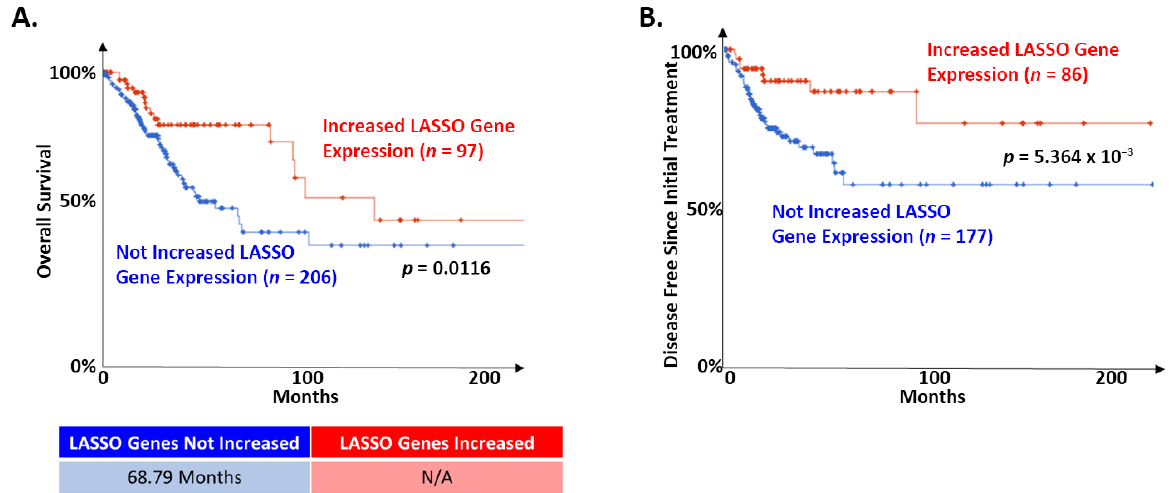
Figure 3. LASSO-identified genes are positive prognostic factors in cervical cancer. The TCGA cervical cancer dataset was segregated based on the expression of LASSO-identified genes as described in the text. ( A ) Of the 303 samples in the TCGA dataset with information on overall survival, 97 had altered expression of at least one LASSO-identified gene. The remaining did not have increased expression of nine LASSO-identified genes (CEBPD, SPRR2G, RAB7B, NOTCH1, KRT16, LCE1B, SLPI, RPS29, and PPL; z-score > 2). Kaplan–Meier curves of the two populations are shown. Median survival for each group is shown below the curve. N/A indicates that the group with altered expression of LASSO-identified genes did not drop below 50%. ( B ) Of the 263 samples in the TCGA dataset with information on maintenance of disease-free status after initial treatment, 86 had increased expression of at least one of the nine LASSO-identified gene analyzed in A. The remaining did not have increased expression of these genes. Kaplan–Meier curves of the two populations are shown. The median survival is not shown because neither group dropped below 50%. For all, the significance of the difference between the two groups was determined by logrank test. The relevant p -values are shown on each curve. Samples where LASSO-identified genes were altered are shown in red. Samples where LASSO-identified genes were NOT altered are shown in